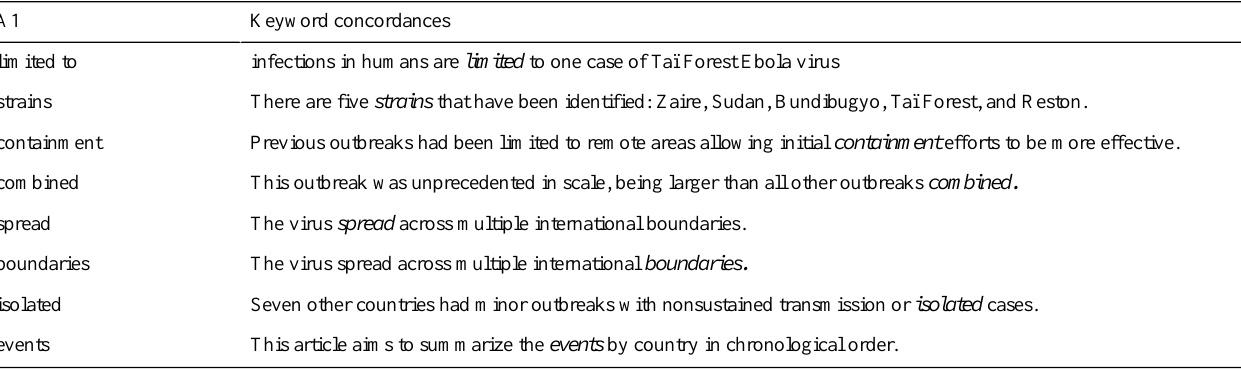
Table 3. A1 in difficult texts. Keyword concordancesA1 infections in humans are limited to one case of Taï Forest Ebola viruslimited to There are five strains that have been identified: Zaire, Sudan, Bundibugyo, Taï Forest, and Reston.strains Previous outbreaks had been limited to remote areas allowing initial containment efforts to be more effective.containment This outbreak was unprecedented in scale, being larger than all other outbreaks combined. combined The virus spread across multiple international boundaries.spread The virus spread across multiple international boundaries. boundaries Seven other countries had minor outbreaks with nonsustained transmission or isolated cases.isolated This article aims to summarize the events by country in chronological